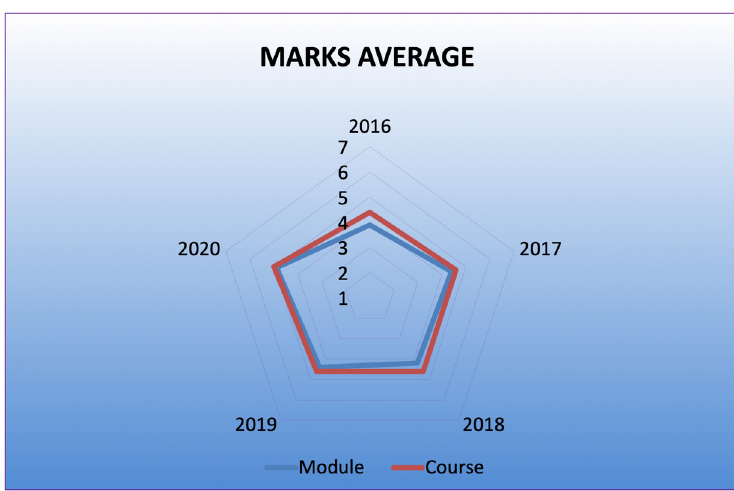
Figure 4. Comparison of average grades for the module and the subject